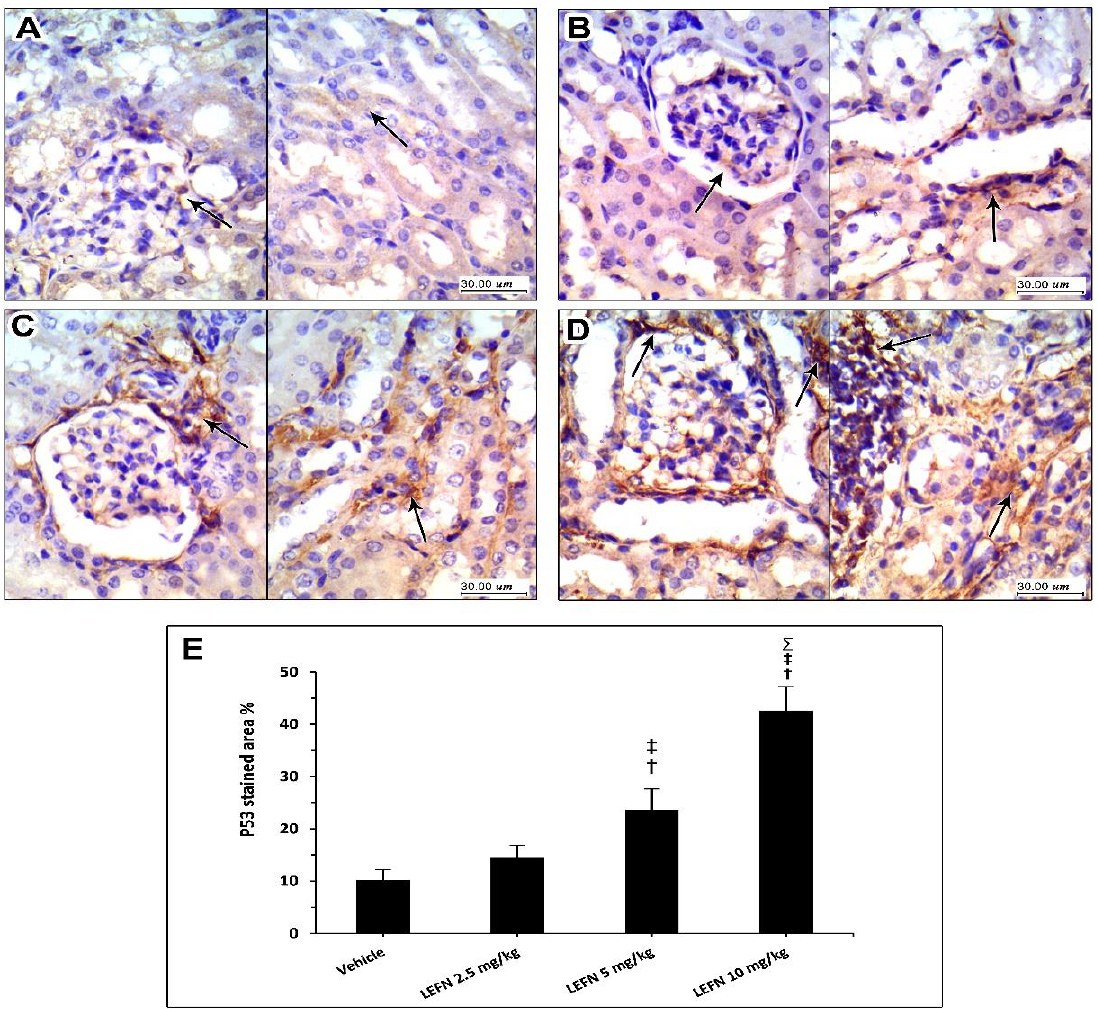
Figure 9. Immunohistochemistry for p53 in the kidney specimens. ( A ) Images from the vehicle group show focal weak p53 staining, localized to periglomerular cells (in left panel) and focal minimal staining in tubular cells (right panel). ( B ) Images from the LEFN 2.5 mg/kg group show a very faint focal staining of p53 in glomerular areas (left panel) and weak staining in peritubular areas (arrow in right panel). ( C ) The LEFN 5 mg/kg group showed focal moderate or weaker staining of p53 encircling periglomerular areas (left panel), and this is also seen in peritubular and perivascular areas (right panel). ( D ) The LEFN 10 mg/kg group revealed moderate to strong staining of p53, with most staining in periglomerular tubules (left panel) and in areas surrounded by inflammatory cells infiltrate (right panel), arrows in all images indicate positive staining ( E ) Column chart for mean ± SD of the stained area % in kidney specimens from the experimental groups and data were analyzed using one-way ANOVA. †: versus the vehicle group, ‡: versus the LEFN 2.5 mg/kg group, and Σ : versus the LEFN 5 mg/kg group at p < 0.05.